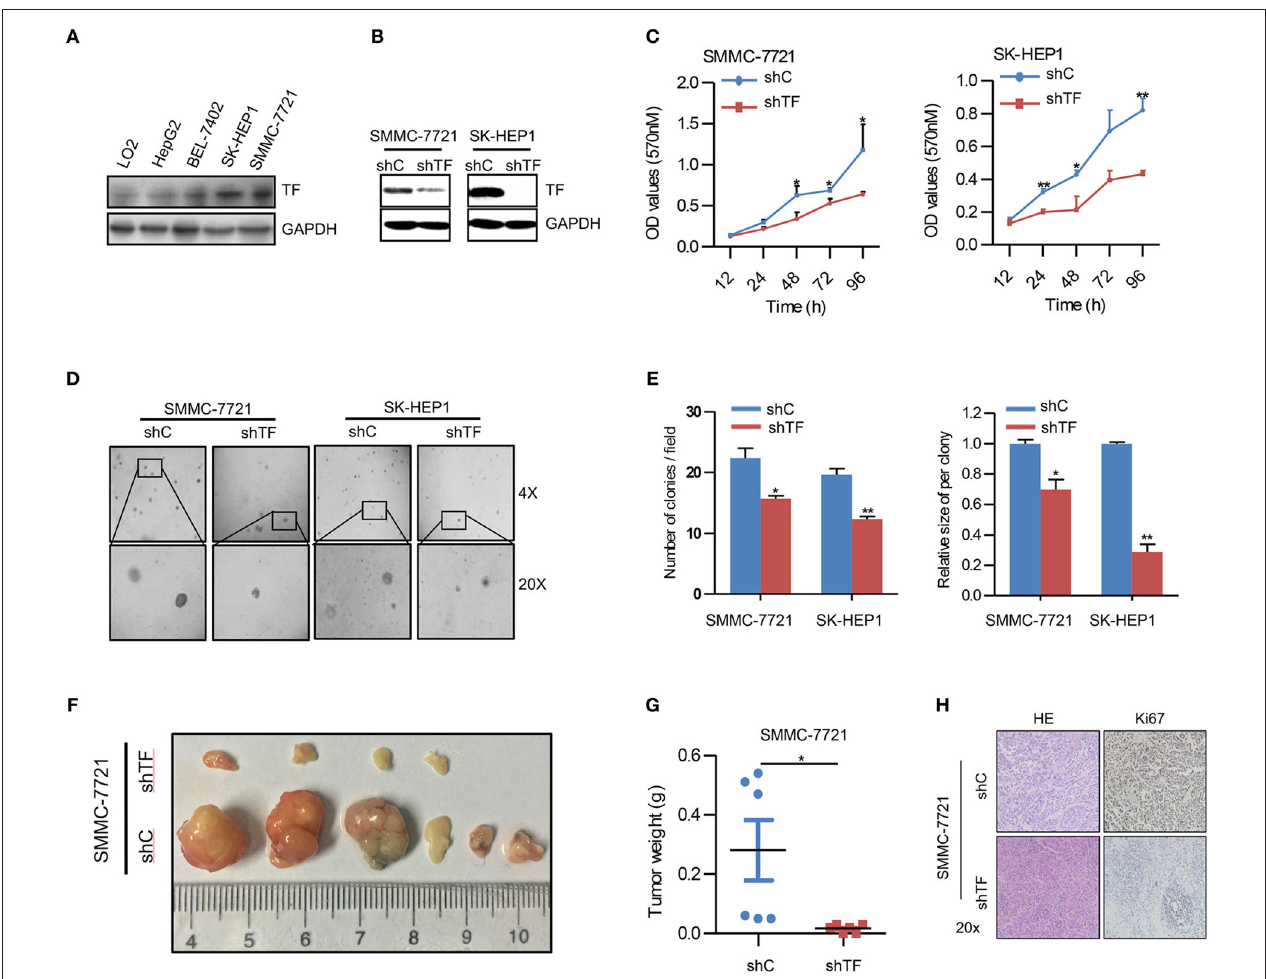
FIGURE 1 | Knockdown of TF inhibits the growth of HCC. (A,B) Western blot analysis of the protein expressions in the indicated cells. (C) Cell growth of the indicated cells as determined with MTT assay. (D) Representative images and (E) quantification of the indicated cells sphere as determined with sphere formation assay. (F) The indicated subcutaneous tumors and (G) tumor weight of nude mice were shown. (H) Representative images of H&E and Ki-67 staining in the indicated tumor sections as determined with IHC assay. Error bars, mean ± SD. * p < 0.05 and ** p < 0.01 [two-tailed Student’s t -test (C,E,G)